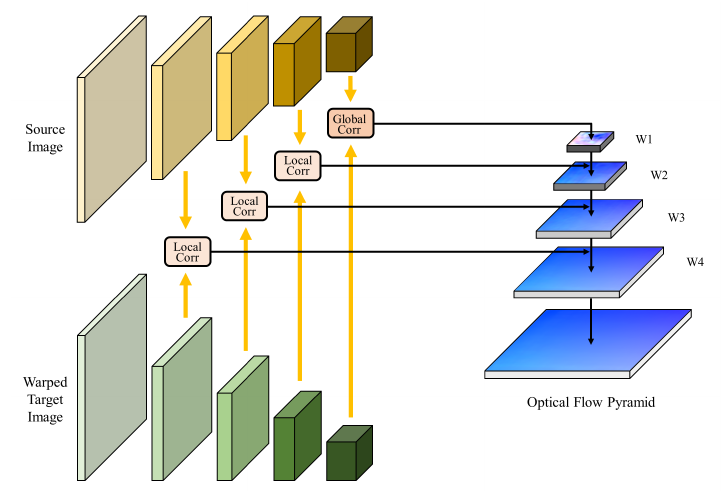
Figure 2. The architecture of the optical flow pyramid with global and local